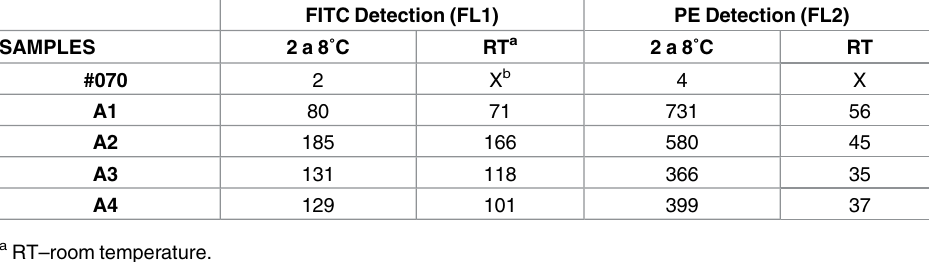
Table 1. FITC and PE detection after anti-IgG-FITC